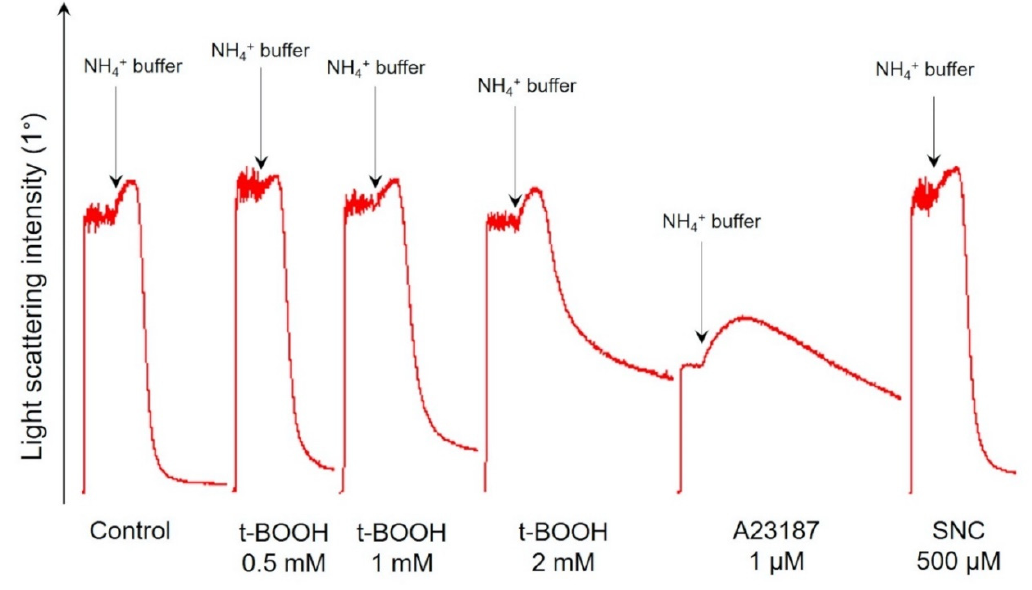
Figure 6. OS dose-dependently decreased RBCs’ deformability and inhibited band 3 function. Representative hemolysis curves of ammonium stress test one of eight experiments. RBCs (0.5 × 10 9 cells / mL) were incubated with the indicated compounds for 1 h, and then aliquots (10 µ L, 10 6 cells / mL final concentration) of samples were resuspended in HEPES bu ff er to register light scattering intensity corresponding to control. Then aliquots (10 µ L, 10 6 cells / mL final concentration) of samples were resuspended in NH 4 + bu ff er for ammonium stress test. Arrows indicate the start of the ammonium stress test. Quantitation of these data is presented in Table